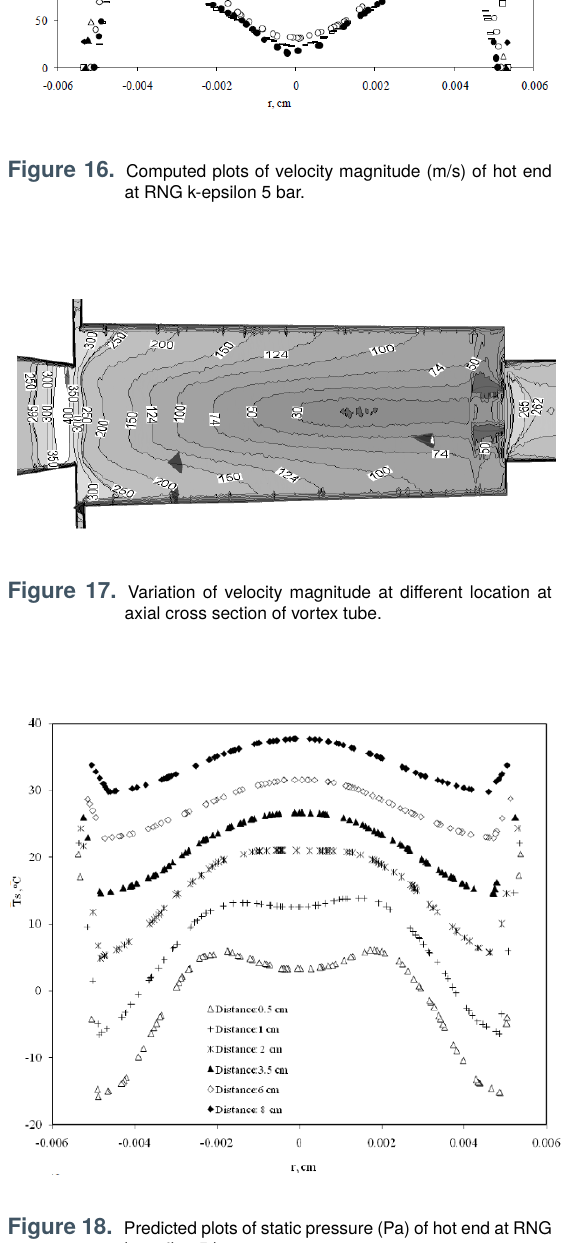
Figure 18. Predicted plots of static pressure (Pa) of hot end at RNG k-epsilon 5